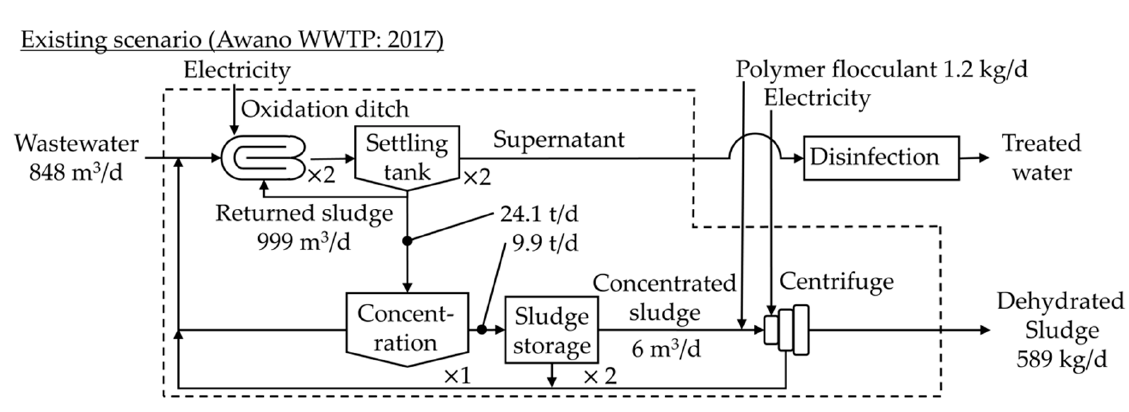
Figure 5. Current estimated system flow at Awano WWTP.